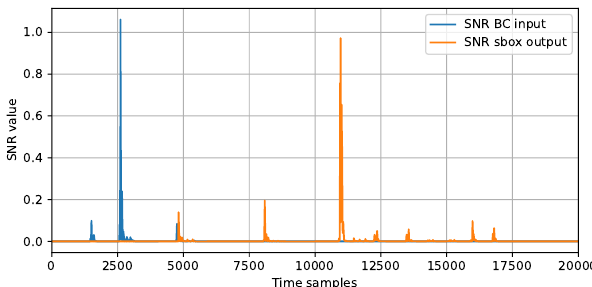
Figure 7: Exemplary SNR curve for the detection of